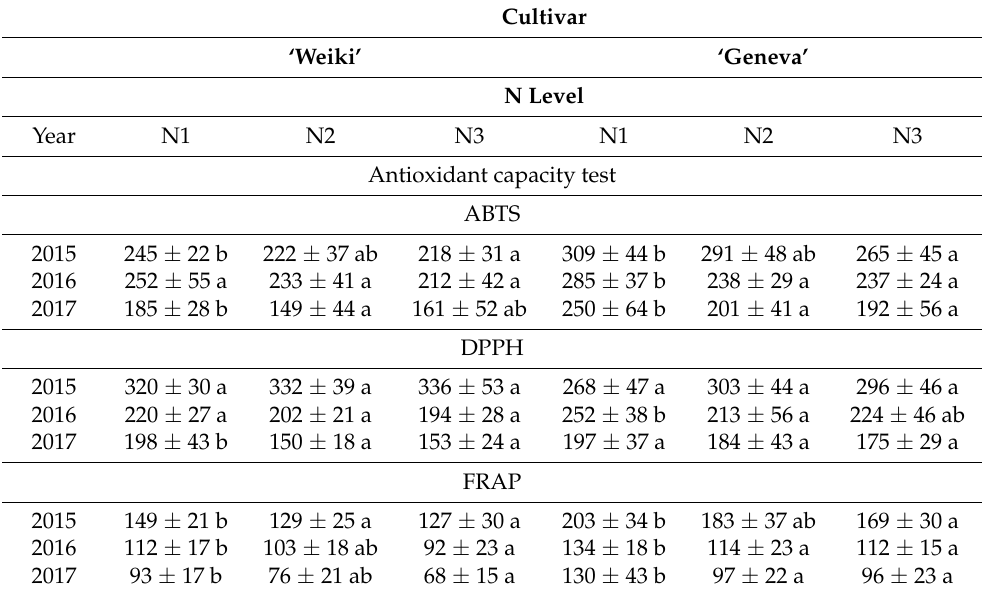
Table 6. Total antioxidant capacity in ABTS, DDPH and FRAP assay tests (mmol TE kg − 1 FW) in two A. arguta cultivars’ leaves depending on soil N level in different growing